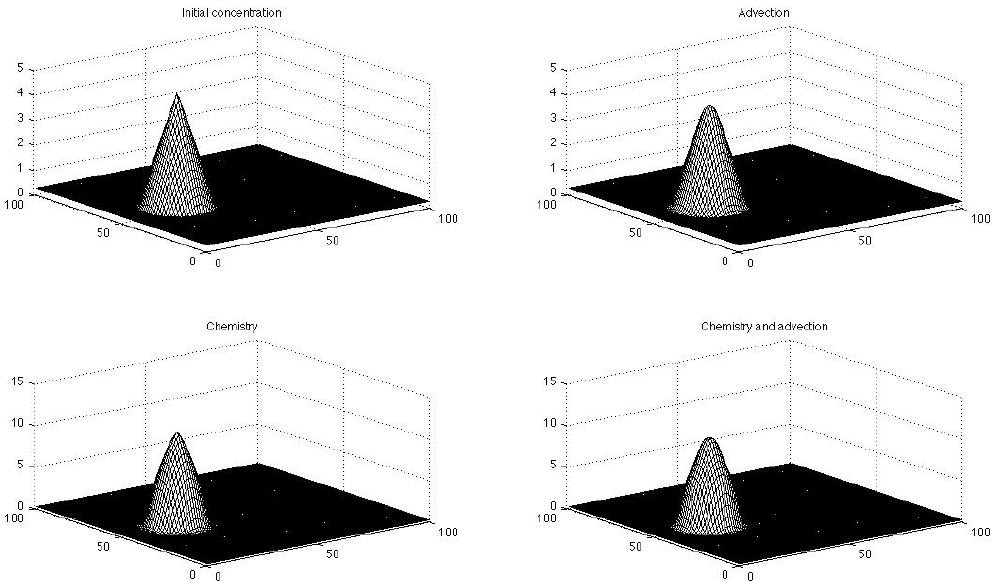
Fig. 4. Rotation test for filtered LMC cascade using the rotating cone for NO 2 with urban conditions and resolution 3 1, with 1t = 270s, 1x = 1 . 0, and C = 0 . 981. The results are given for the initial condition (top left) and model runs with pure advection (top right), pure chemistry (bottom left), and combined chemistry and advection (bottom right). The minimum and maximum values for the respective plots are: Top left: min=0.2406, max=4.729. Top right: min=0.2406, max=4.263. Bottom left: min=0.1328, max=11.31. Bottom right: min=0.0838, max=10.56.